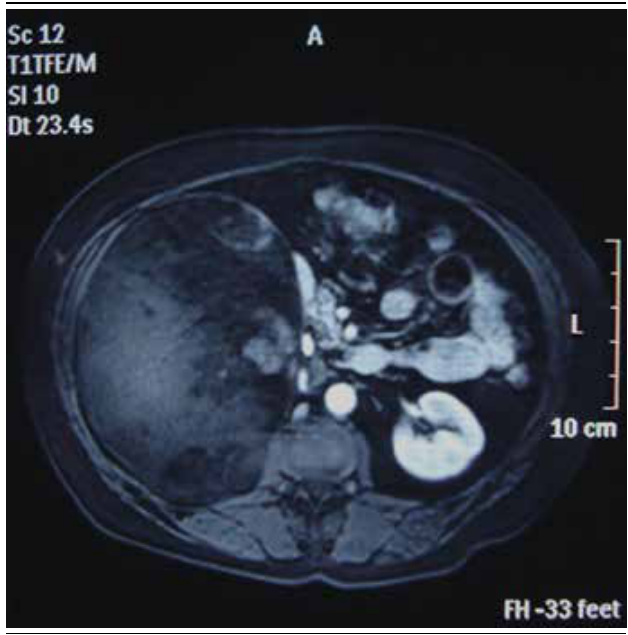
figuRE 1 − Axial slice of abdomen MRI showing a large well-defined expanding solid cystic lesion, with areas of both hyper- and hypo-intense signal on T1 with contrast enhancement MRI: magnetic resonance imaging; T1: spin-lattice relaxation time.